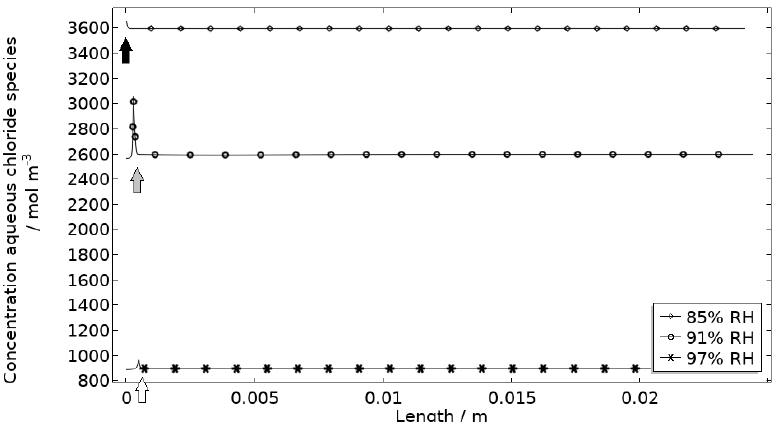
Figure 12. Modeled aluminum concentrations profiles after 2.5 h exposure along the calibration cell with 86 μg NaCl/cm2 load at 21 °C at 85%, 91%, and 97% RH. Black, grey, and white arrows mark the location of the corroding surface for exposure at 85%, 91%, and 97% RH.